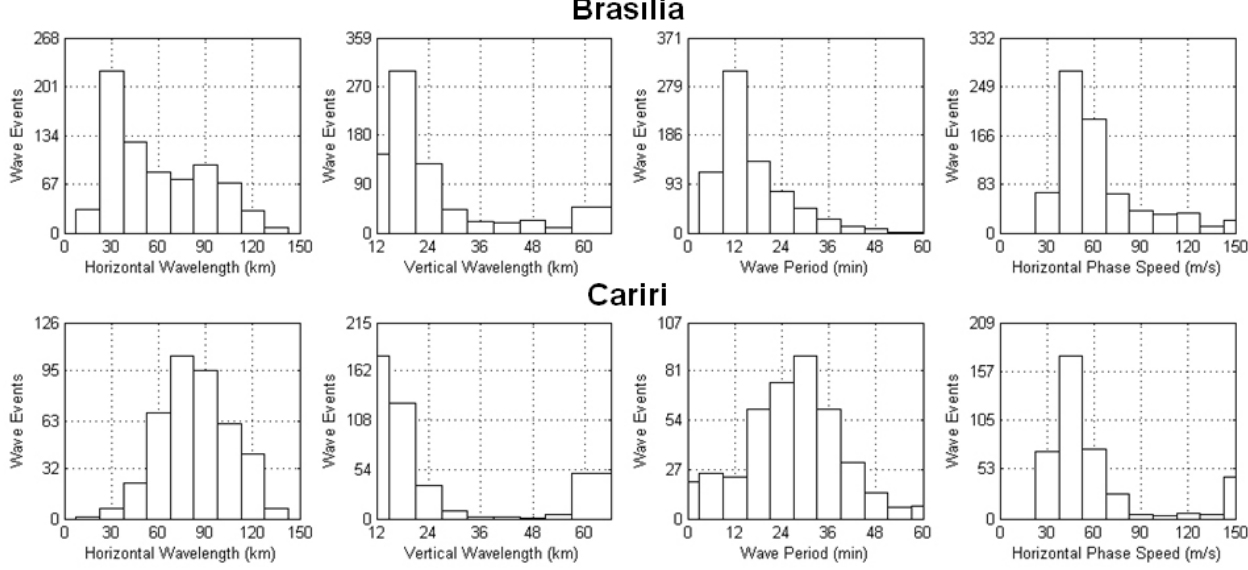
Fig. 3. Histograms of gravity wave parameter distributions in both sites, Brasilia and Cariri. In Brasilia the parameter are observable quantities (extrinsic), while in Cariri the parameters are